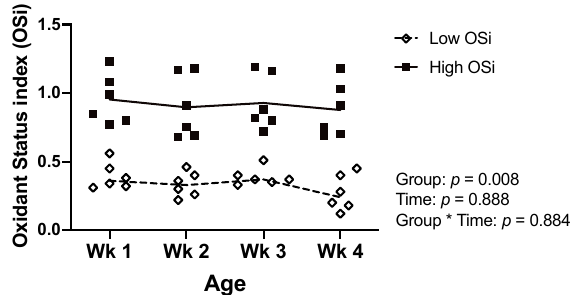
Figure 1. Values of the oxidant status index (OSi) of the 12 calves of Experiment 1 throughout the first 4 weeks (wk) of age according to the OSi group. Data are presented as individual values with lines connecting the means.